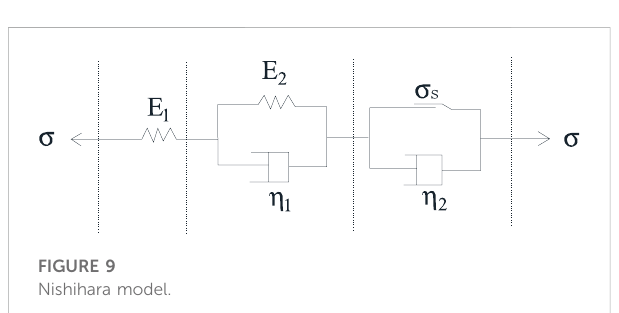
FIGURE 9 Nishihara